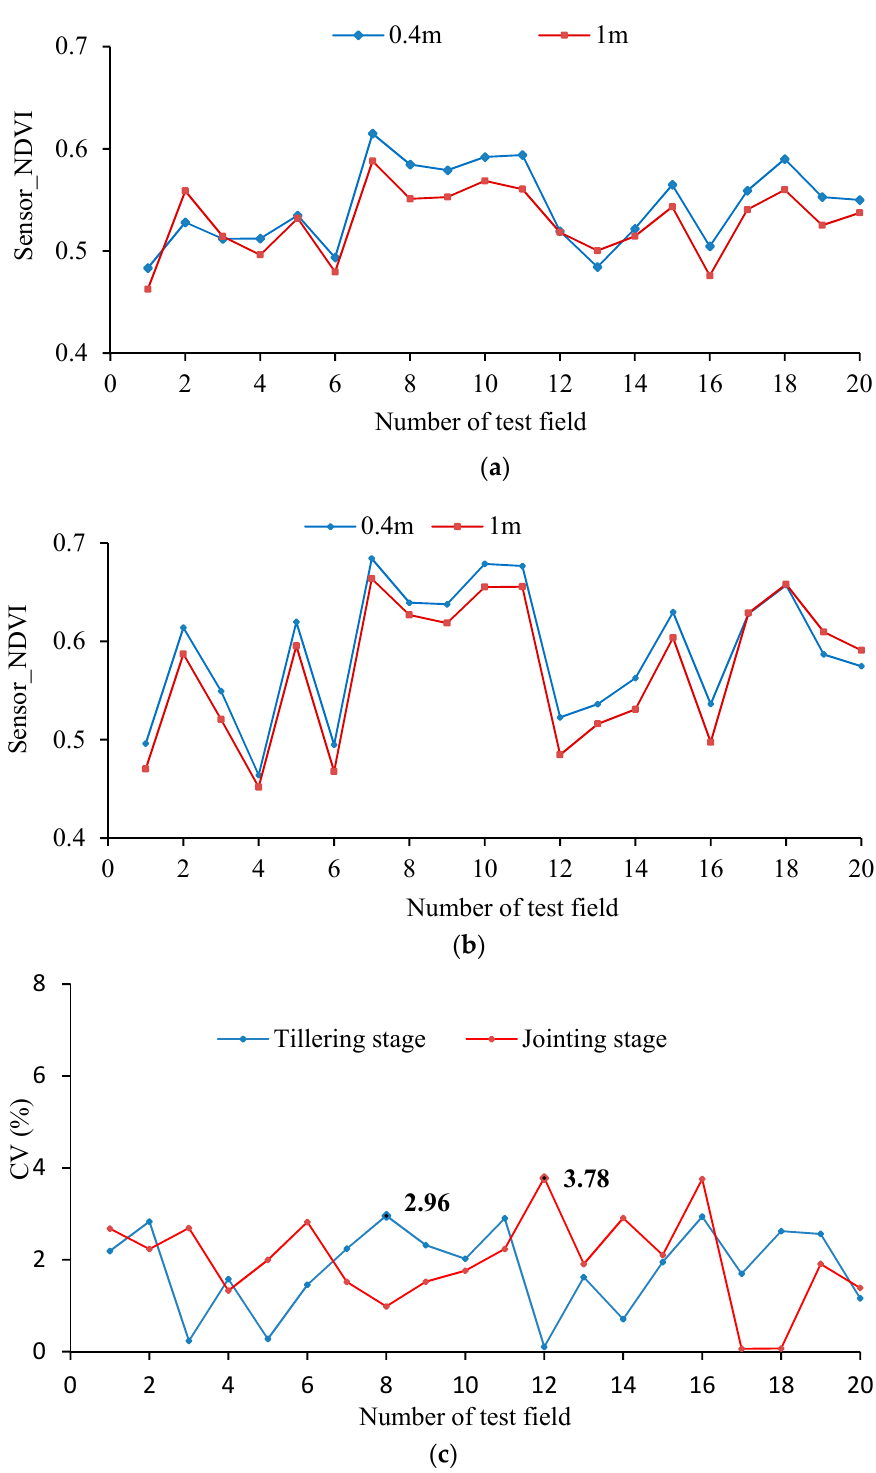
Figure 13. NDVI values measured using the hand-held sensor at different elevations. ( a ) Tillering stage; ( b ) Jointing stage; ( c ) Deviation coefficients of the NDVI values measured.